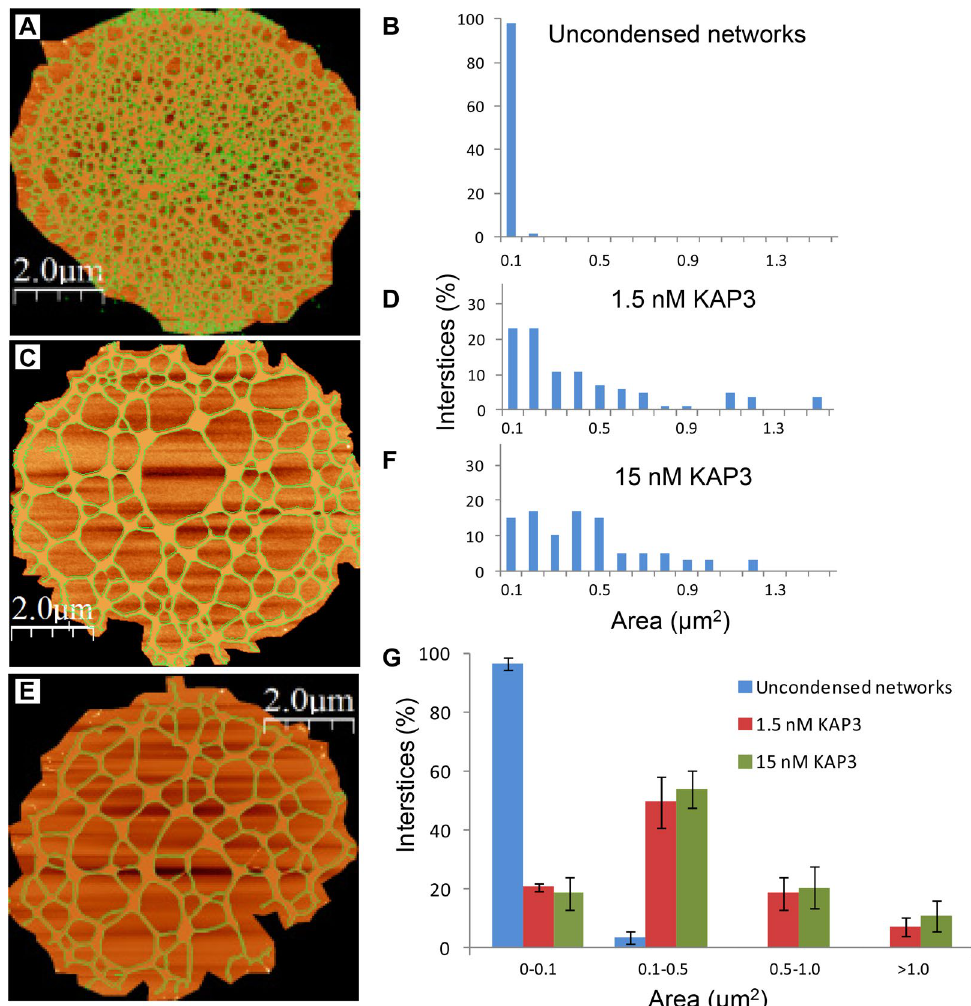
The network interstices are highlighted in green. (B,D,F) The size distribution of the network’s interstices and quantification of the area occupied by each interstices’ size-group in the networks, presented in (A,C,E) , respectively. Bars are 2 µm. (G) The average abundance of interstices (in percentage of the overall networks population) is plotted against KAP3 concentrations. Networks analyzed: uncondensed kDNA networks (n = 10) and condensation intermediate networks, generated in the presence of 1.5 nM (n = 6) and 15 nM KAP3 (n = 6). Standard deviation is